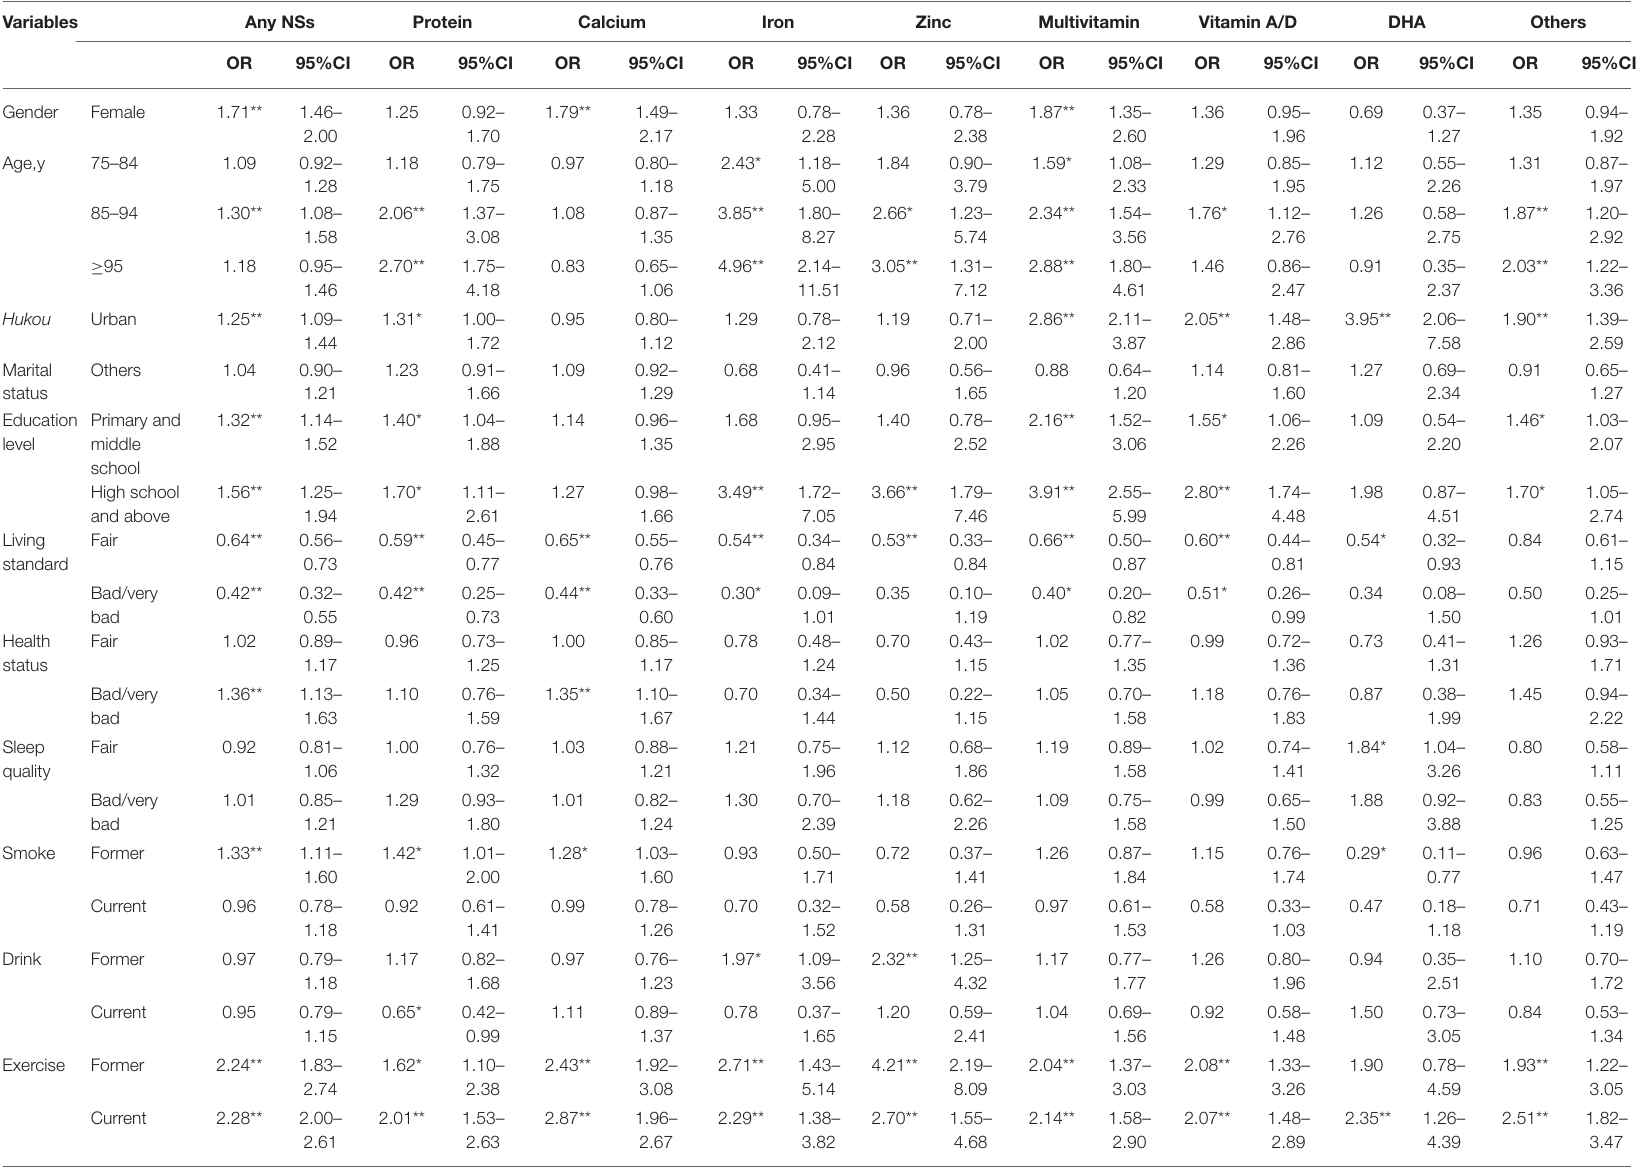
TABLE 2 | Logistic regression analysis of factors associated with NSs